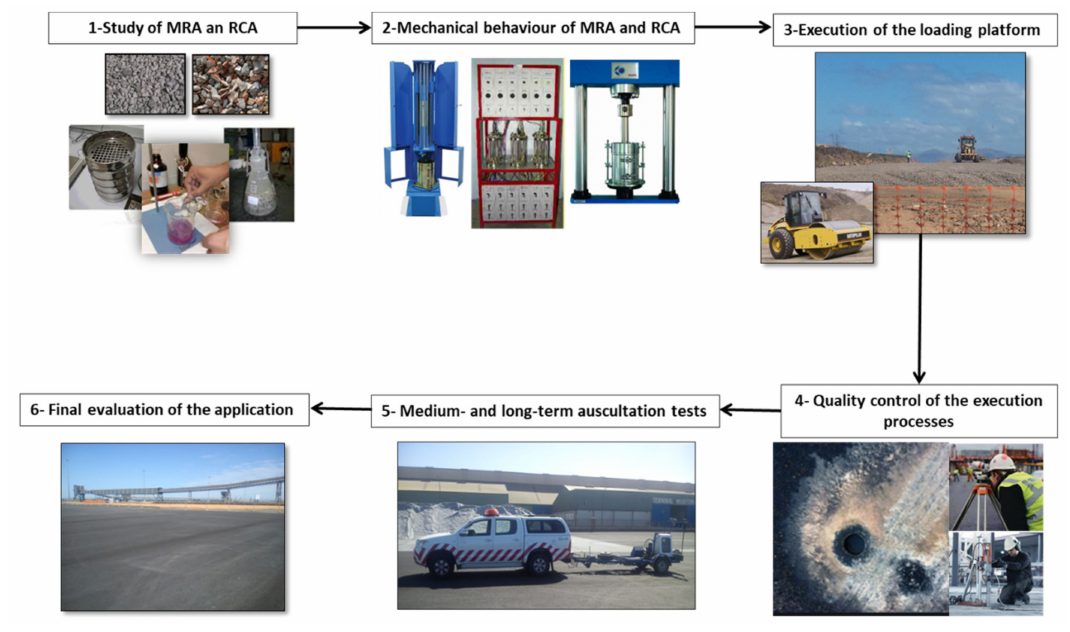
Figure 2. Research